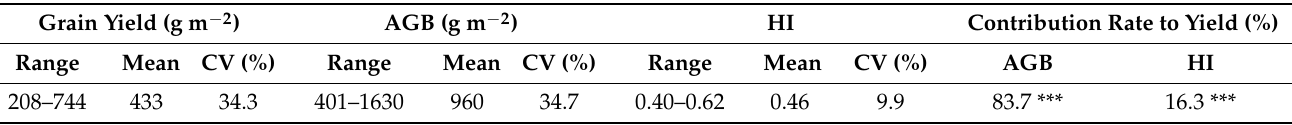
AGDM and HI to grain yield in winter wheat grown from 2017–2020. *** p < 0.001.